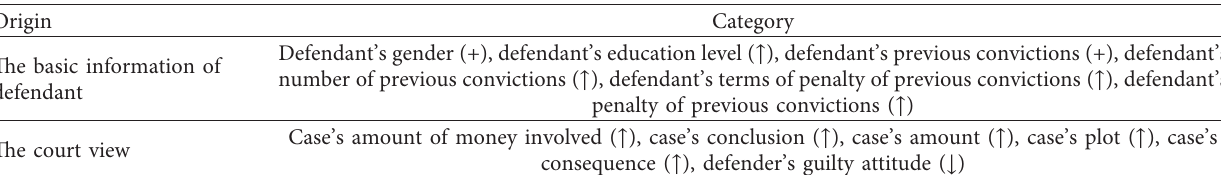
Table 1: Origins and categories of structured